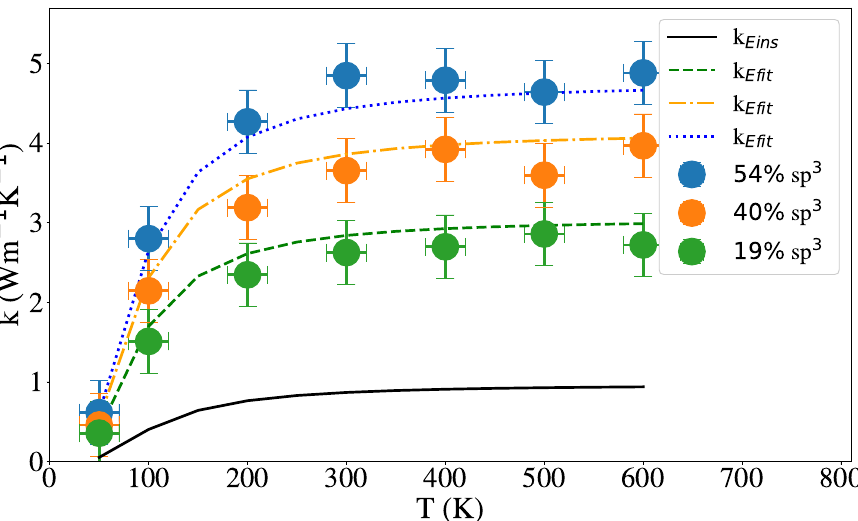
Figure 8. Thermal conductivity vs. temperature for NW with three different hybridization values. The solid line represent the Einstein limit given by Equation (3), the dashed, dash-dotted and dotted lines represent Equation (6) for the NW of 19%, 40% and 54% of sp 3 hybridization